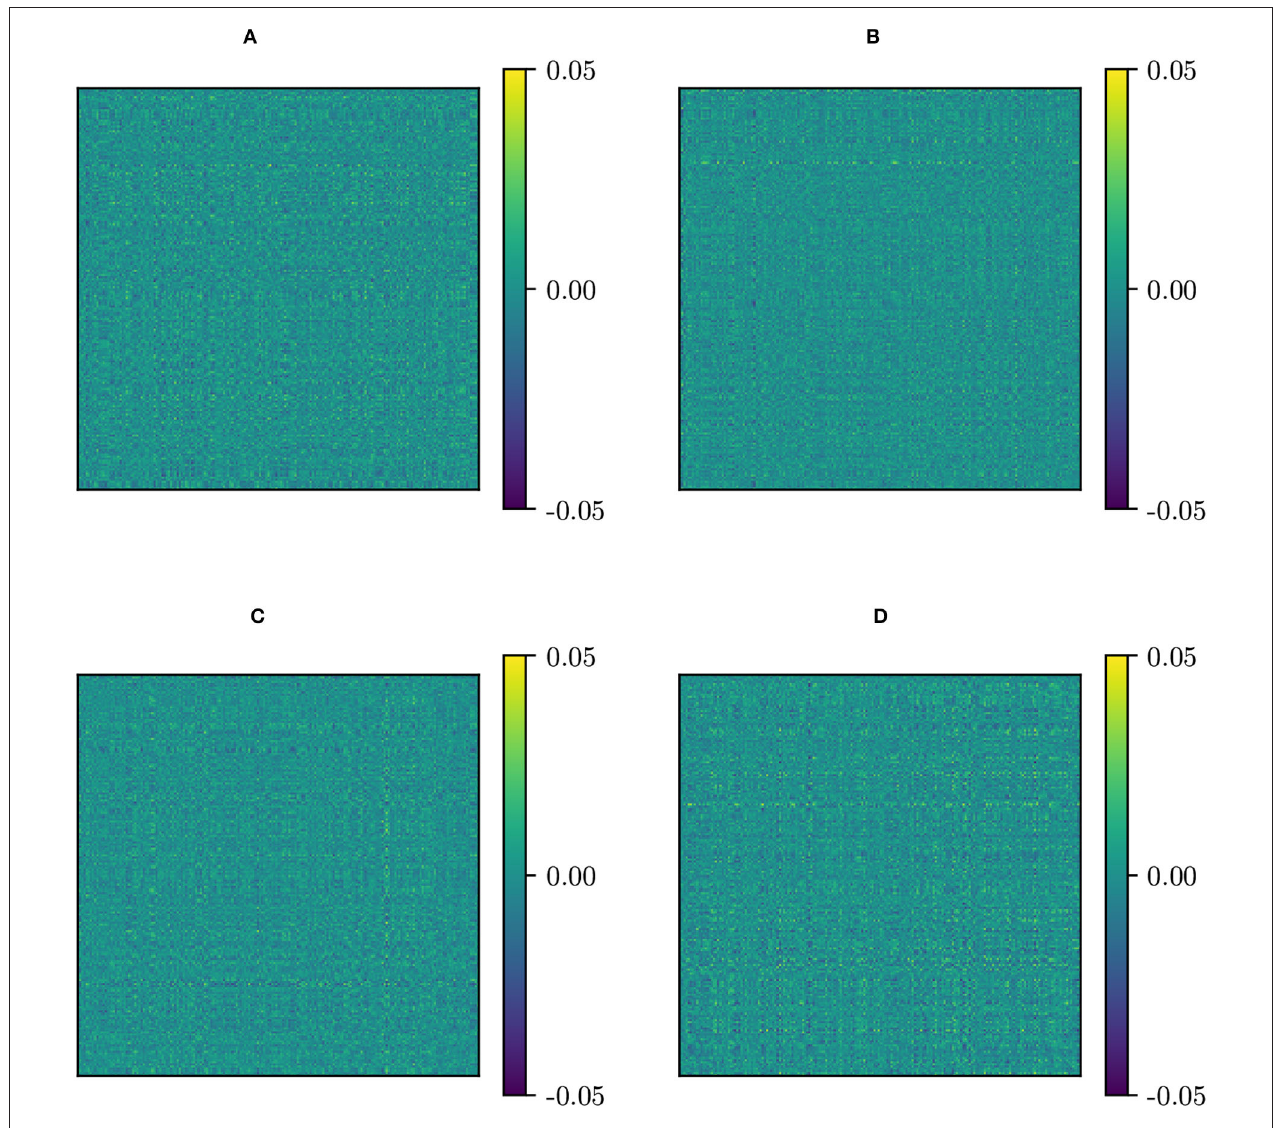
FIGURE 2 | Commutators of the global mean 6 and original site Fréchet mean { 6 ( k ) } . (A) [ 6 , 6 (KKI) ] ; (B) [ 6 , 6 (NYU) ] ; (C) [ 6 , 6 (PKG) ] ; (D) [ 6 , 6 (NIM) ] . (KKI, Kennedy Krieger Institute, Johns Hopkins University; NYU, New York University Child Study Center; PKG, Peking University; NIM, NeuroIMAGE sample).